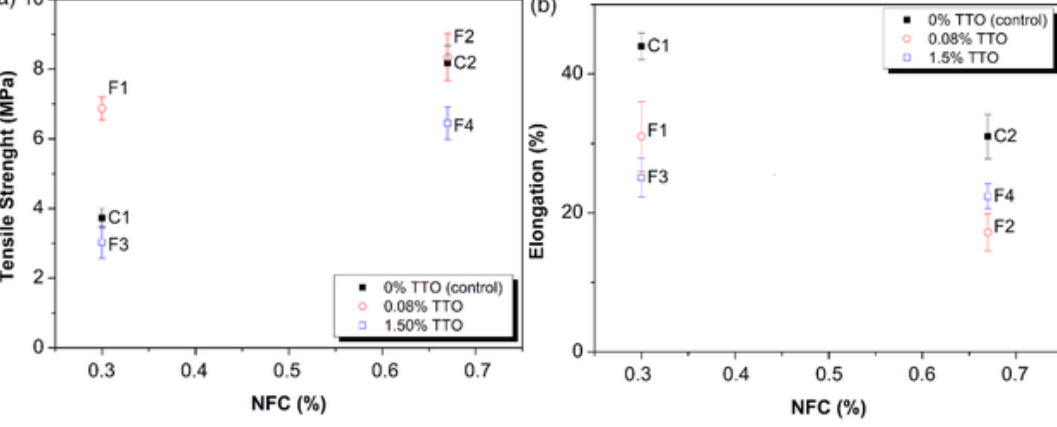
Figure 3. TS ( a ) and Elongation ( b ) of the films for different levels of NFC and TTO. Control films: C1 (0.3% m/v , NFC); C2 (0.67% m/v , NFC); and films with TTO: F1 (0.3% m/v , NFC, 0.08% v/v , TTO); F2 (0.67% m/v , NFC; 0.08% v/v , TTO); F3 (0.3% m/v , NFC; 1.5% v/v , TTO); F4 (0.67% m/v , NFC; 1.5% v/v , TTO). (Reproduced with a copyright permission from Silveira et al. [61]).